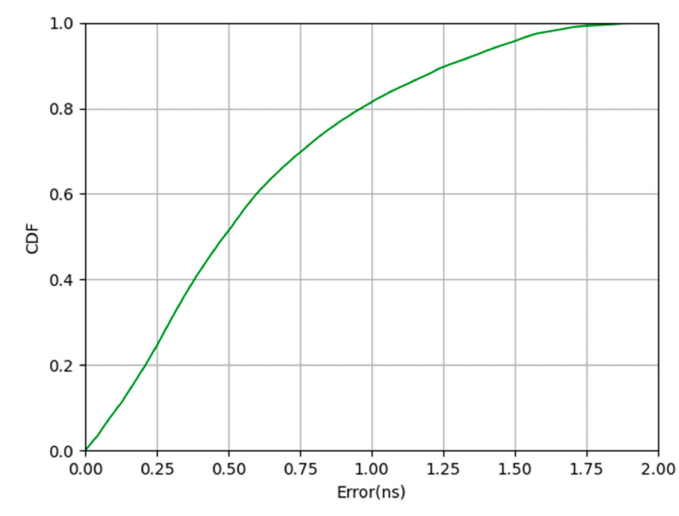
Figure 5. Experimental results of time synchronization with synchronization packets.